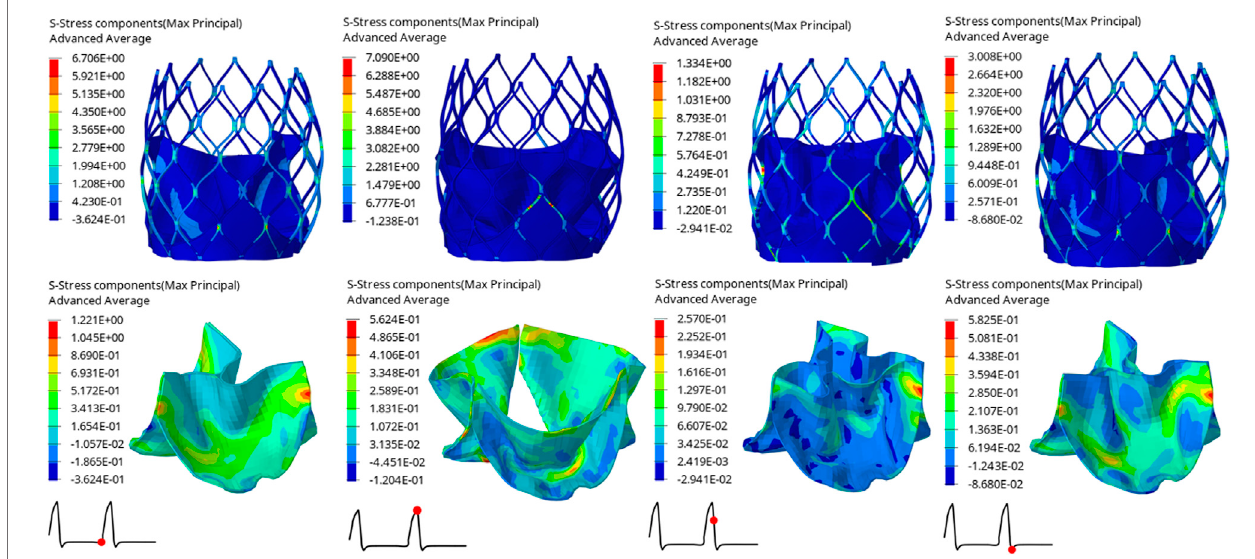
FIGURE 9 | Maximum principal stress distribution of valve stent and valve lea fl et of model A.